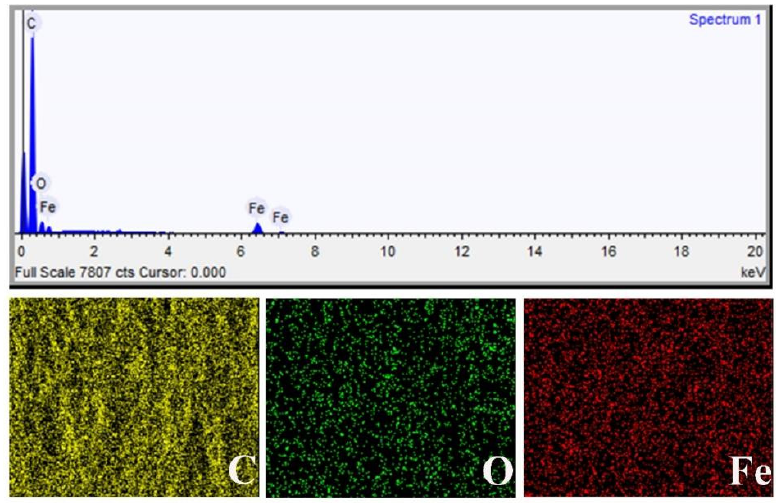
Figure 3. SEM images of Fe 2 O 3 /CNFs (effect of time): ( a ) 1 h; ( b ) 2 h; ( c ) 3 h; ( d ) 4 h; ( e ) 5 h; ( f ) 6 h.